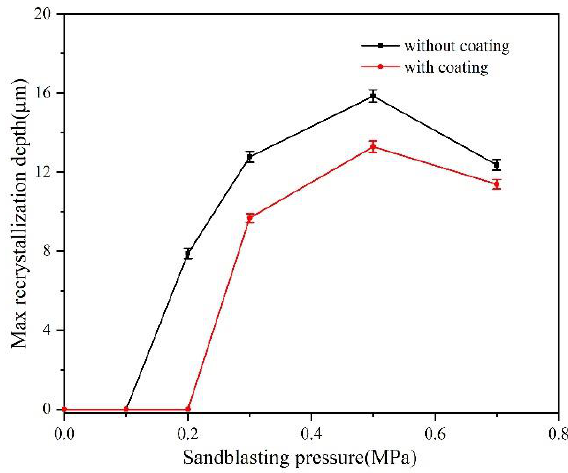
Figure 8. Relationship between the maximum recrystallization depth and sandblasting pressure.